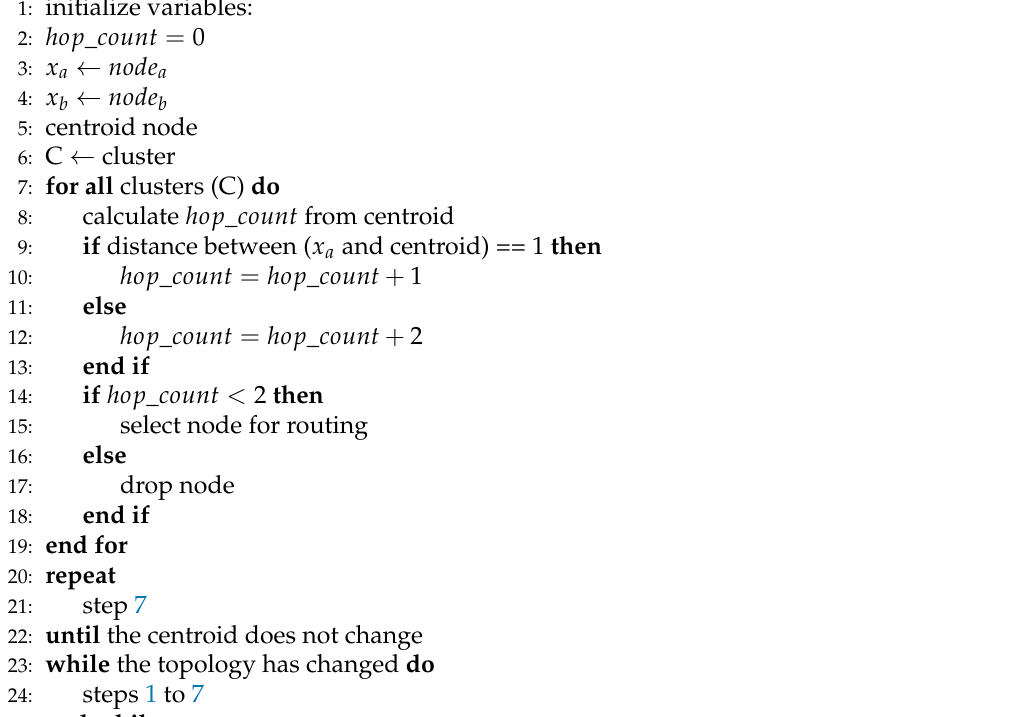
Algorithm 2 Route optimization with the minimum spanning tree